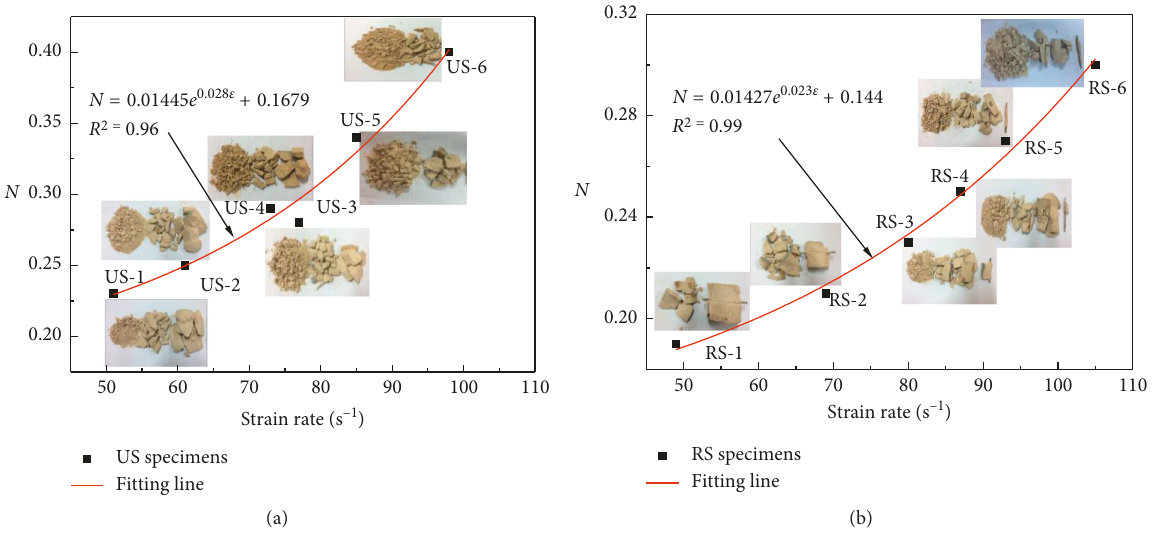
Figure 11: Relation between energy dissipation ratio and strain rate. (a) US samples. (b) RS